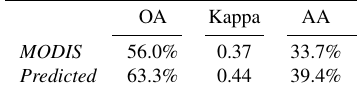
Table 3. Baseline network training configurations.